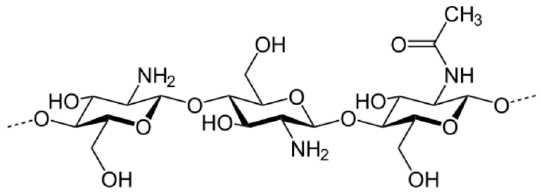
Figure 6. Chemical formula of chitosan—copolymer of D -glucosamine and N -acetyl- D -glucosamine.